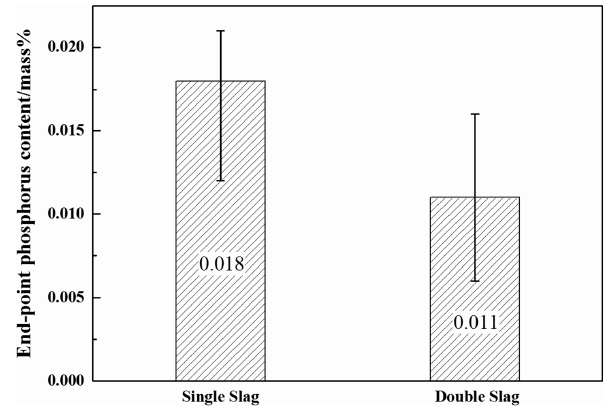
Figure 11: Comparison of end-point phosphorus content between single- and double-slag process.